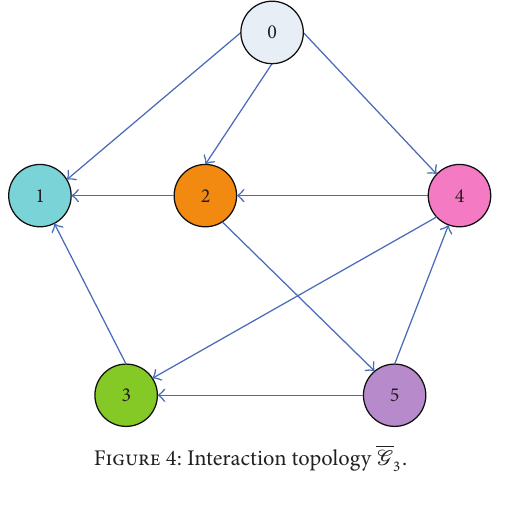
Figure 4: Interaction topology G 3 .